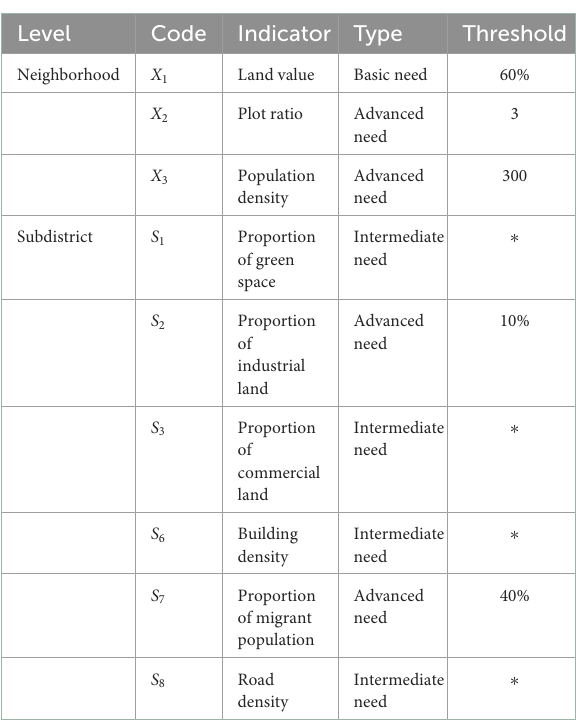
TABLE 5 Summary of